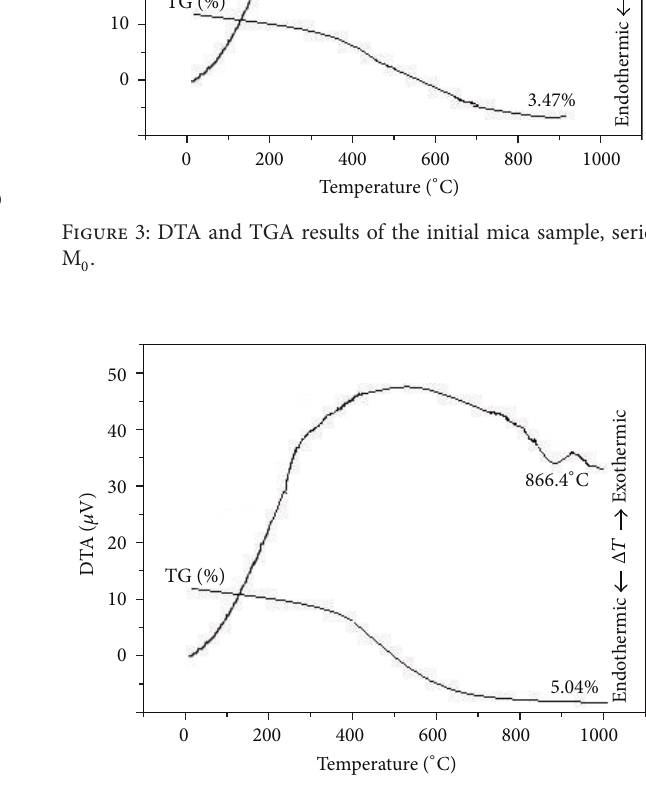
Figure 4: DTA and TGA results of the micronized mica sample, series M 4